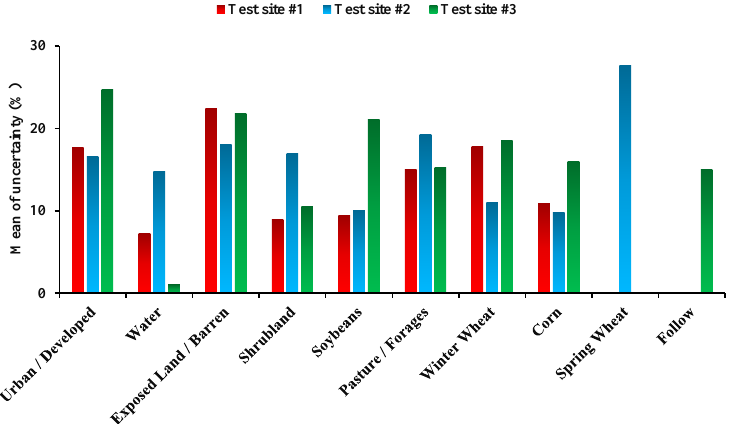
Figure 6. Mean uncertainty of each land crop/cover classes classification for test site 1, 2, and 3. Based on the commission and omission error results for various scenarios, the mod- eling accuracy of each scenario was evaluated (Table 2). Wheat crop errors had the highest amount compared to other crops. Among different areas, test site 3 had the highest error.